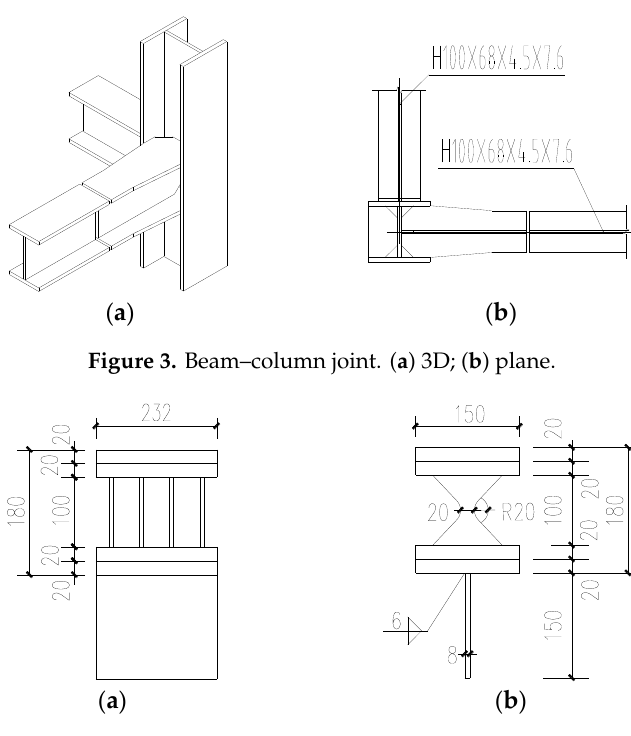
Figure 4. Energy absorbers (unit: mm). ( a ) Front; ( b ) side.